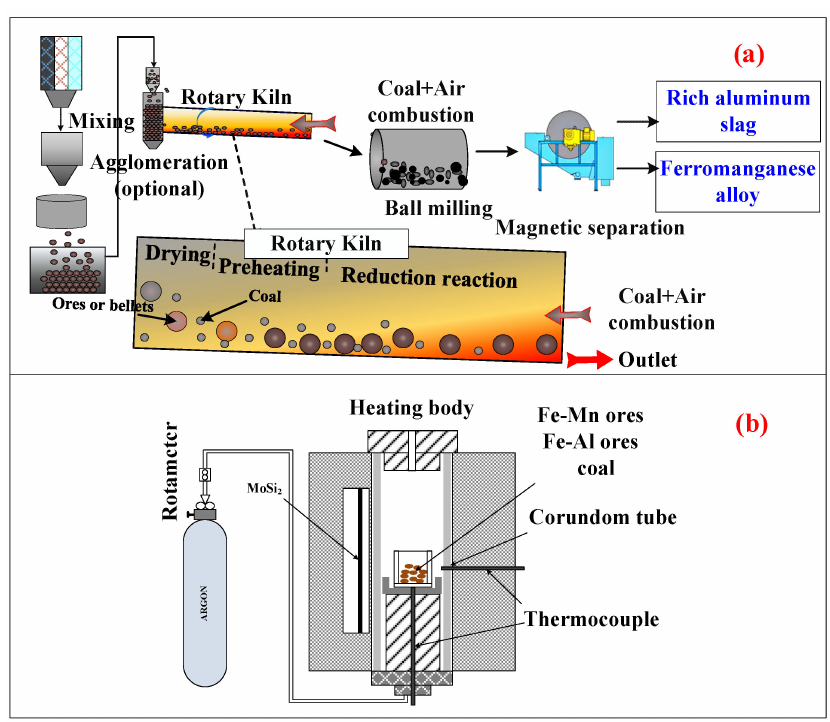
Figure 2. ( a ) Schematic diagram of the industrial separation of Al, Mn and Fe from Fe-Al ores/Fe-Mn ores inside a rotary kiln; ( b ) Schematic diagram of experimental equipment for the carbothermic co-reduction